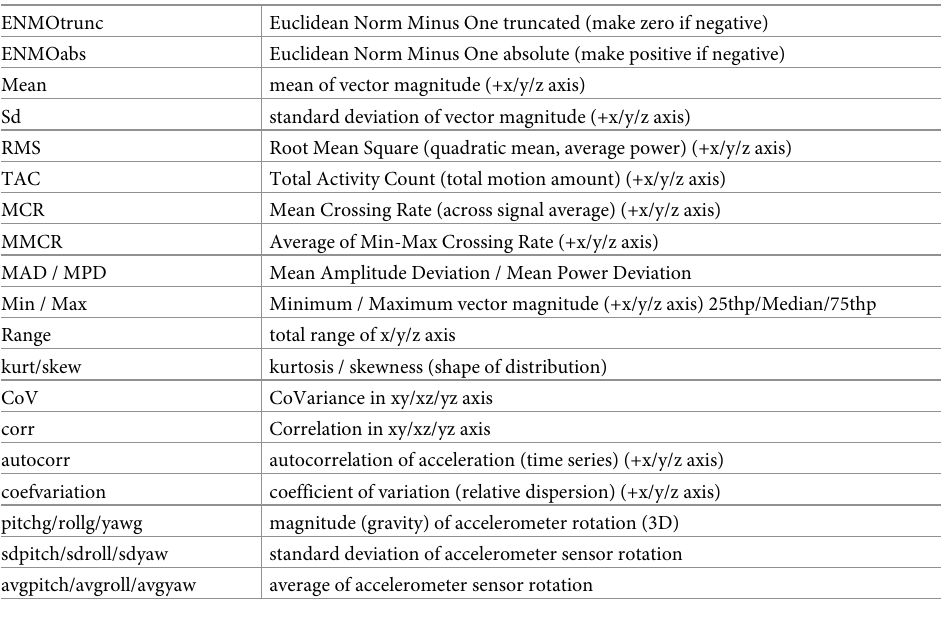
Table 2. Continuous Features from Sensor Records via Participant